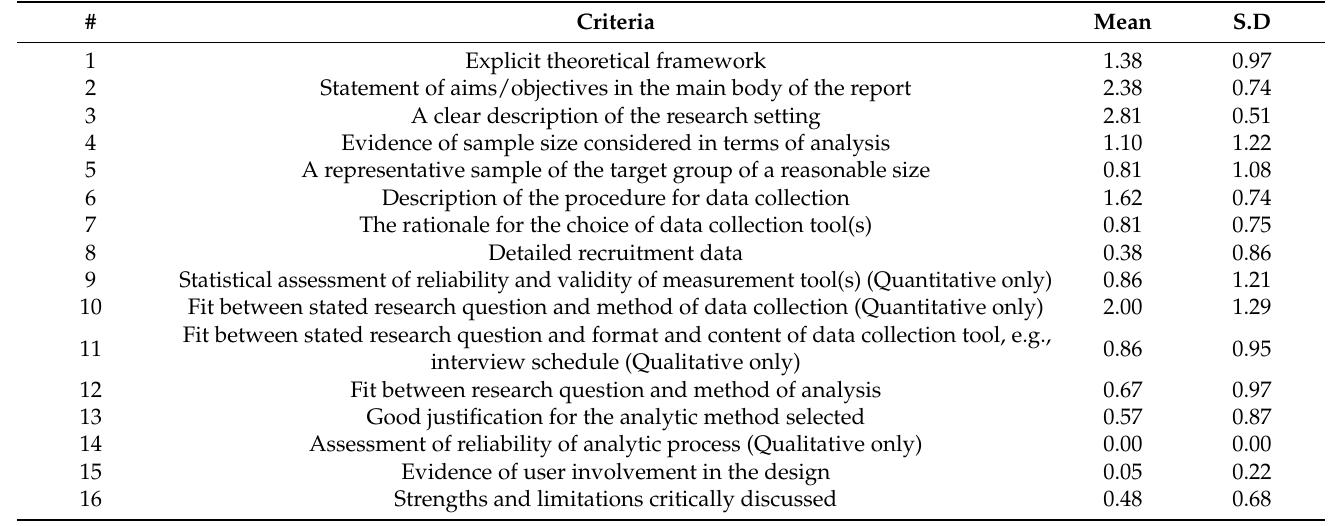
Table 2. List of criteria used to assess the methodological quality of the studies included in the